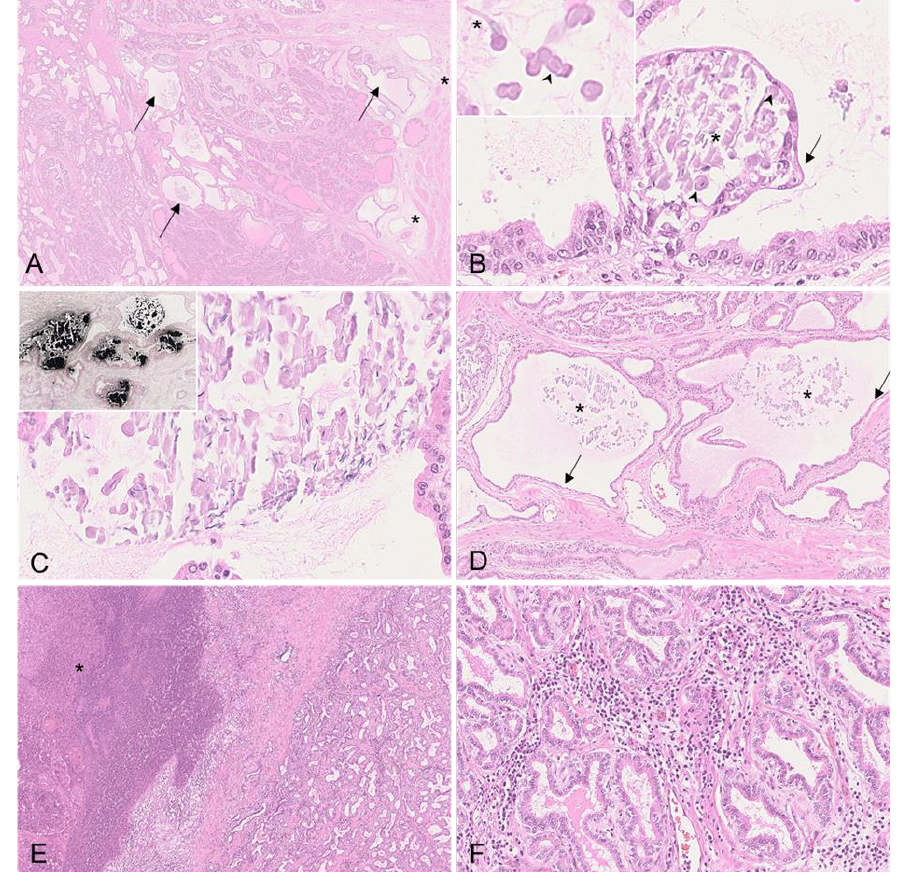
Figure 7. Histopathology of the prostate of ASFV-infected boars. ( A ) HE, boar #3; cystic dilation of secretory tubules (arrow) and mild edema of the fibromuscular tissue (asterisk). ( B ) HE, boar #3; vesicle formation within a secretory tubule. The vesicle was filled with sloughing epithelial cells, few spermatozoa (asterisk), and corpora amylacea (arrowhead). The vesicle was lined by a flattened, degenerating epithelium (arrow). Inset: Magnification of luminal corpora amylacea (arrowhead) and spermatozoa (asterisk). ( C ) HE, boar #3; the luminal content was largely mineralized. Inset: Mineralization of tubular content was confirmed by von Kossa stain. ( D ) HE, boar #3; in several areas, dilated secretory tubules (asterisk) were lined by flattened epithelial cells (arrow). The mineralized content is indicated by the asterisk. ( E ) HE, boar #4; suppurative-to-necrotizing prostatitis with demarcated abscess (asterisk). ( F ) HE, boar #4; interstitial infiltration by plasma cells of the remaining tissue adjacent to the